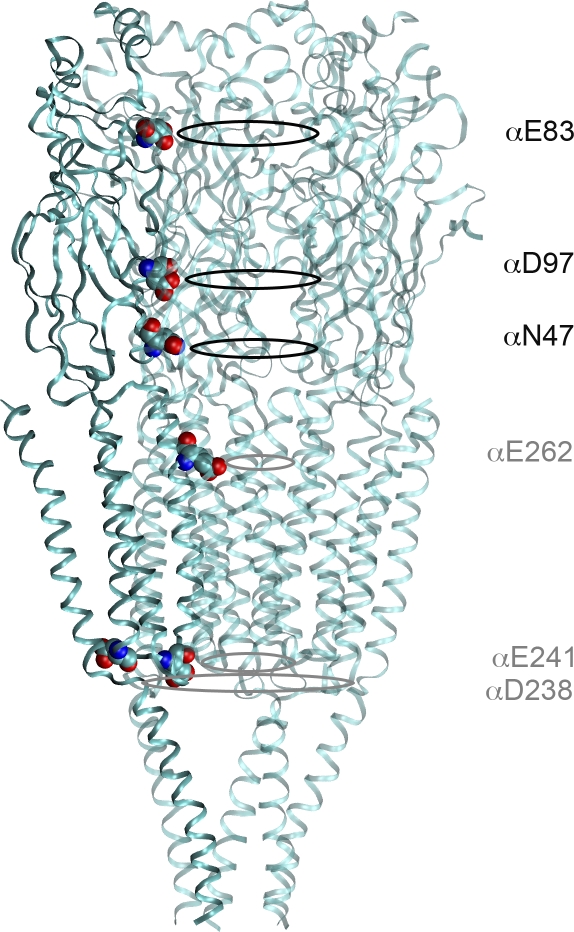
Homology Model of the Human Adult Muscle nAChR Used in the SimulationsRings of charged residues in the extracellular lumen flanking TMD2 are shown. Rings and labels in gray indicate previously described rings of charged residues that affect conductance and selectivity (1), whereas rings in black indicate newly identified residues associated with prolonged cation dwell times in Figures 2 and 4.